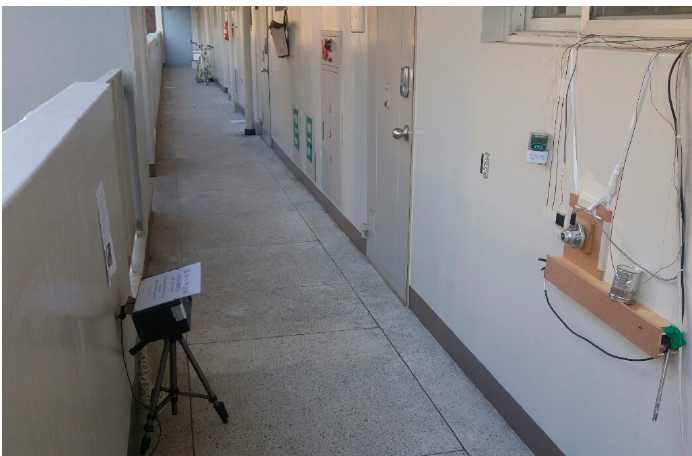
Figure 1. Photograph of the test wall and measurement equipment.